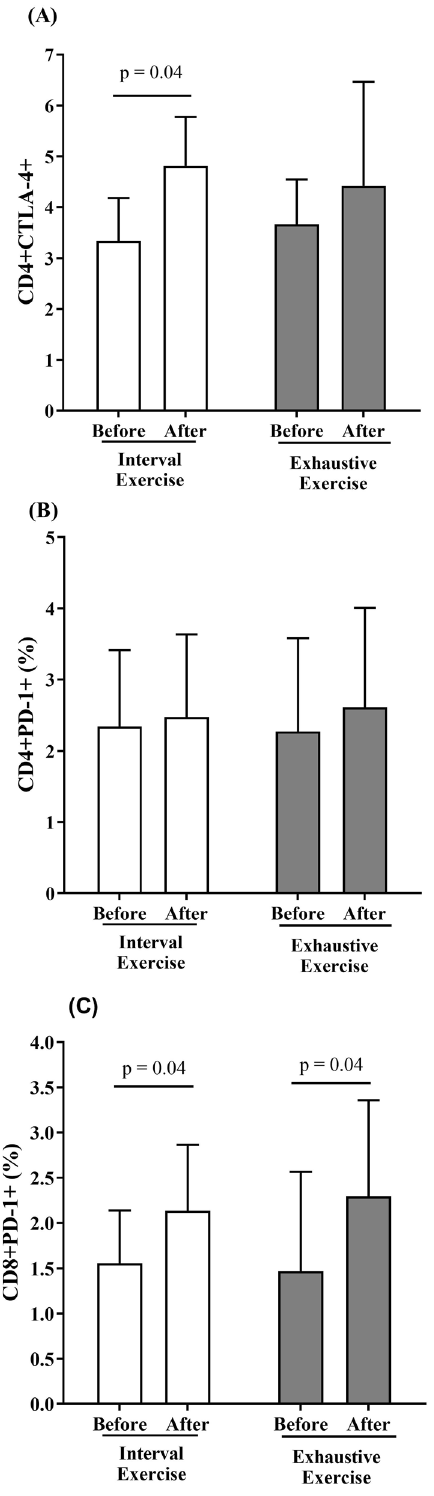
Figure 5. CD4 + and CD8+ T cells expressing PD-1 or CTLA-4 following in vitro incubation with autologous serum from before (white bars) and after (black bars) two types of exercise. The frequencies of CD4 + CTLA-4 + ( 4A ), CD4 + PD-1 + ( 4B ) and CD8 + PD-1 + ( 4C ) T cells were analyzed by flow cytometry after in vitro PBMC stimulation with serum collected before and immediately after high-intensity interval exercise (HIIE) or exhaustive exercise. Statistical analysis conducted by two-way repeated measurements ANOVA with Bonferroni’s post hoc ( p <